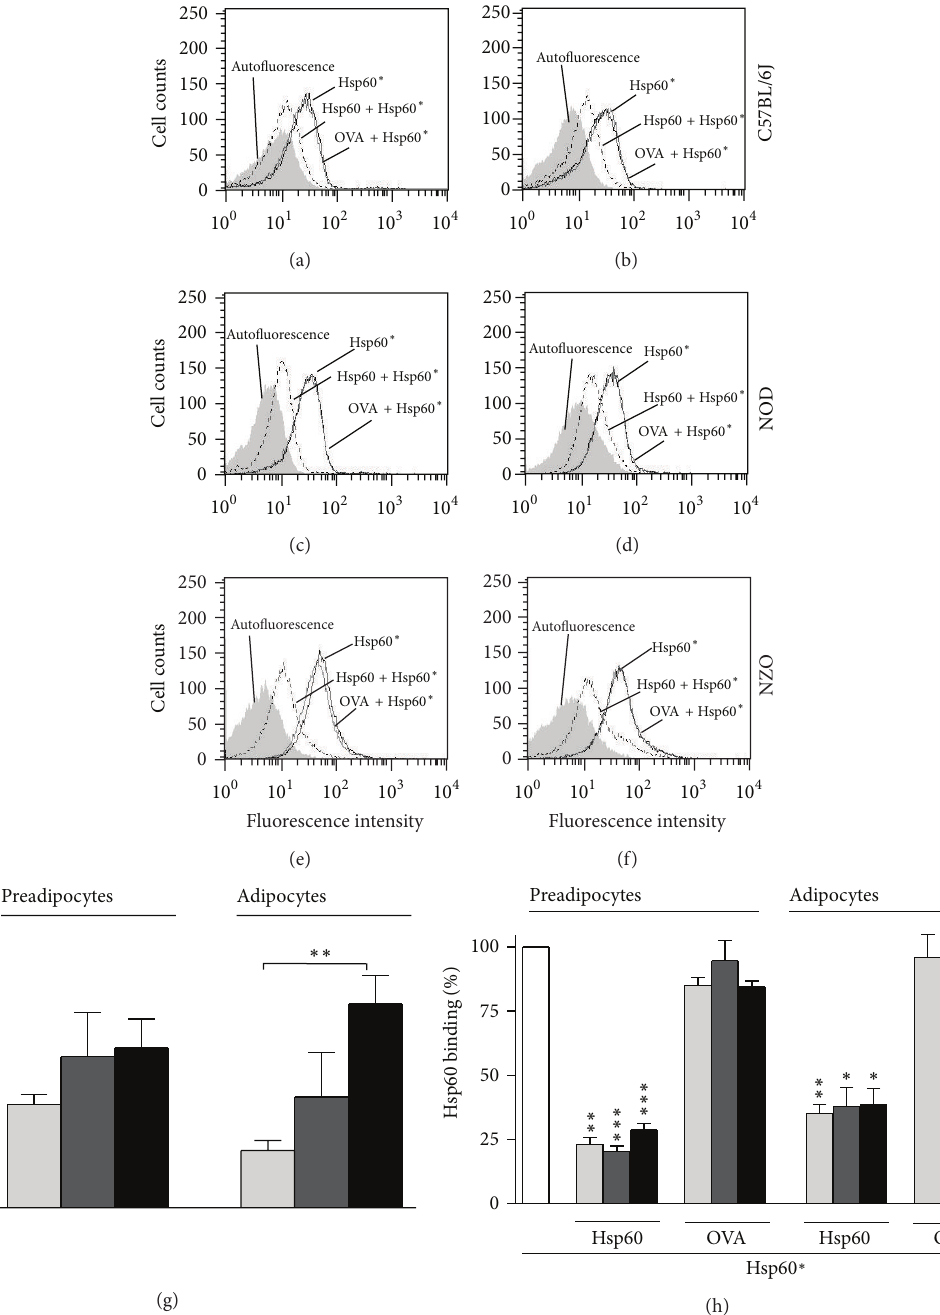
Figure 1: Hsp60 binding to C57BL/6J, NOD, and NZO mouse-derived (pre-)adipocytes. Preadipocytes (a, c, e) or adipocytes (b, d, f) of the three mouse strains were incubated with 100 nM DyLight649-labeled Hsp60 (Hsp60 ∗ ) in the absence or presence of 1 𝜇 M unlabeled Hsp60 or OVA. Binding of Hsp60 ∗ was quantified by determining the mean fluorescence intensities (geo mean) of the cell populations using FACS analysis. The data show representative results of Hsp60 ∗ binding and inhibition studies (a–f) and of Hsp60 ∗ binding to C57BL/6J (light grey bars), NOD (dark grey bars), and NZO mouse-derived cells (black bars) as means + SEM of three independent experiments (g). The specificity of Hsp60 ∗ binding was proven by analyses of the effects of unlabelled Hsp60 or OVA (h). The data represent residual Hsp60 ∗ binding to C57BL/6J (light grey bars), NOD (dark grey bars), and NZO mouse-derived cells (black bars) as percent of Hsp60 ∗ binding (set as 100%, white bar) in the absence of Hsp60 or OVA. The data show means + SEM of three independent experiments. ∗ 𝑃 < 0.05 , ∗∗ 𝑃 < 0.01 , ∗∗∗ 𝑃 < 0.001 compared to other mouse strains (g) or compared to Hsp60 ∗ binding in the absence of Hsp60 or OVA